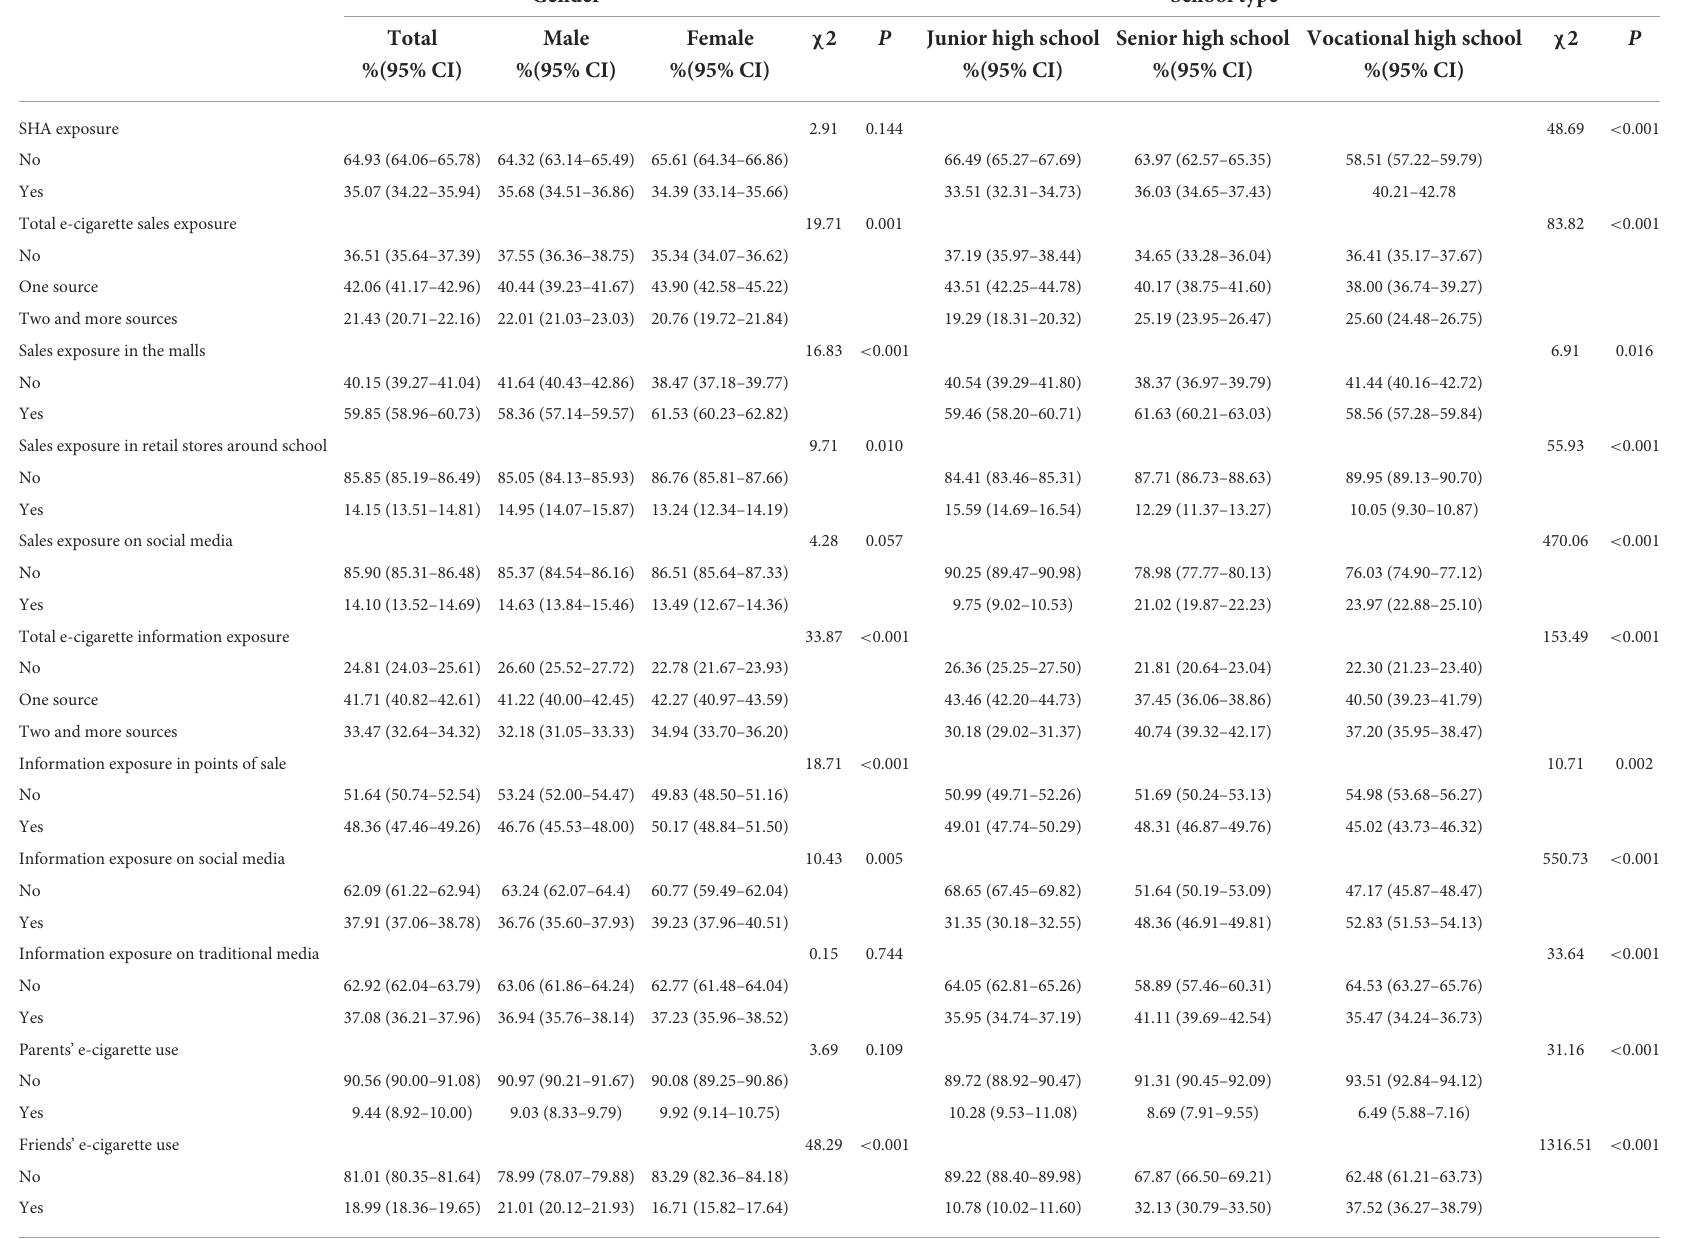
TABLE 2 Social environment exposure to e-cigarettes among